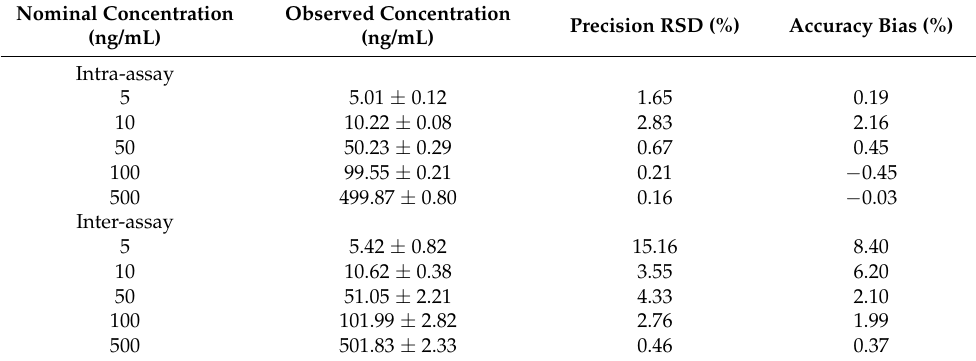
Table 1. Method validation for the intra-assay precision (%RSD) and accuracy (%Bias) of the HPLC method for the determination of schizandrin in plasma.